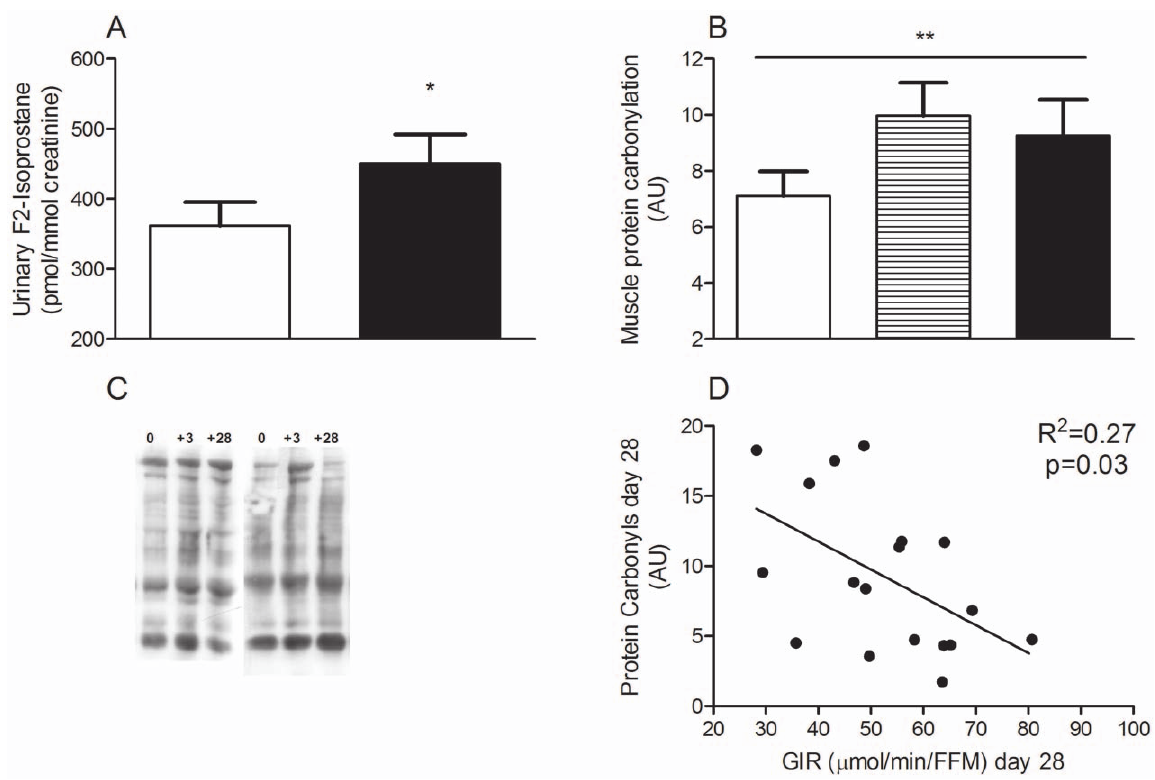
Figure 2. Urinary F2-isoprostane content and skeletal muscle protein carbonyls in response to overfeeding. Urine F 2 -isoprostane (A), skeletal muscle protein carbonyls quantification (B) and representative blots (C) and the association between protein carbonyls and peripheral insulin resistance at end of overfeeding (D). Data are expressed as mean 6 SEM at baseline (white), day 3 (striped) and day 28 (black) of overfeeding. Difference by RM-ANOVA * P , 0.05, ** P =0.01, urinary F2-isoprostanes data is based on n =37 (18 men and 17 women) and skeletal muscle protein carbonyl on n =18 (8 men and 10 women).